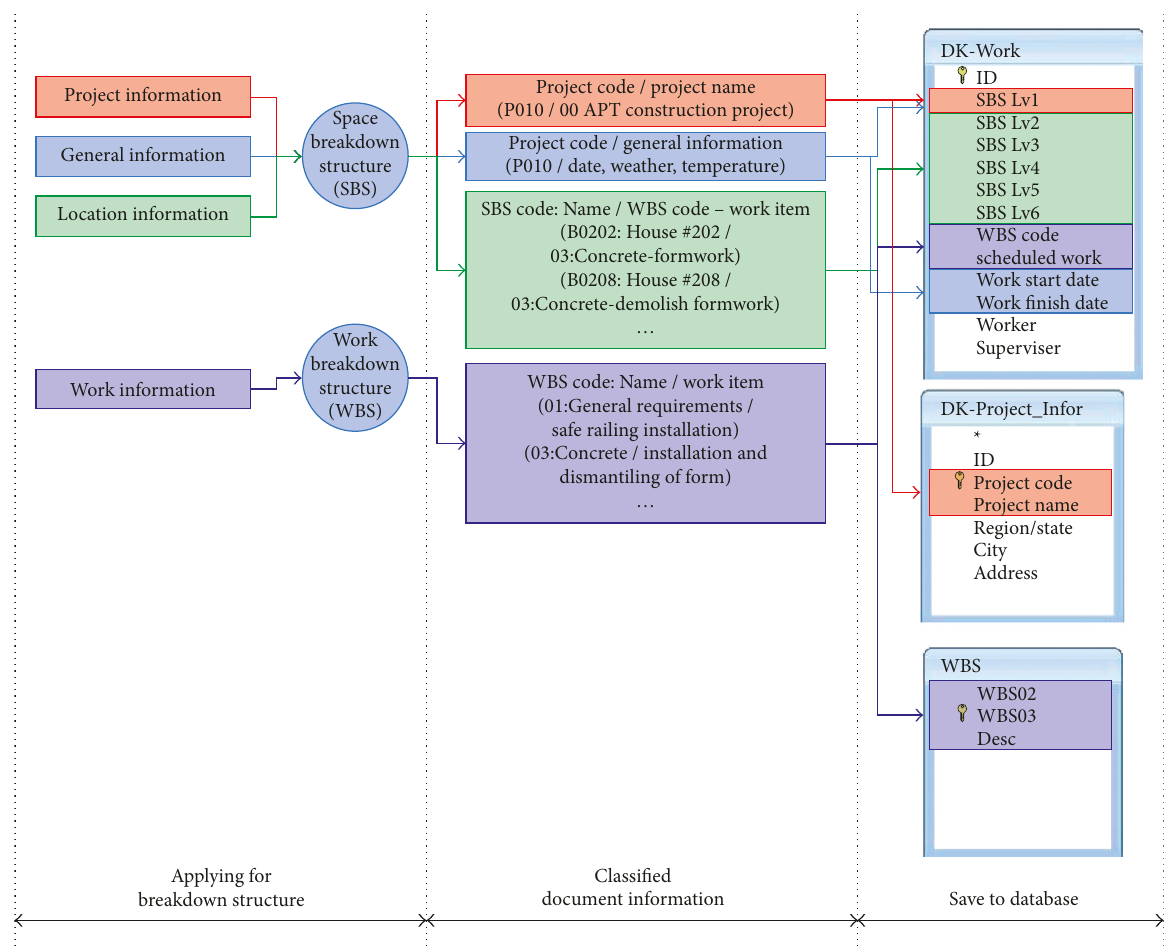
Figure 4: Example of storing categorized construction data in a